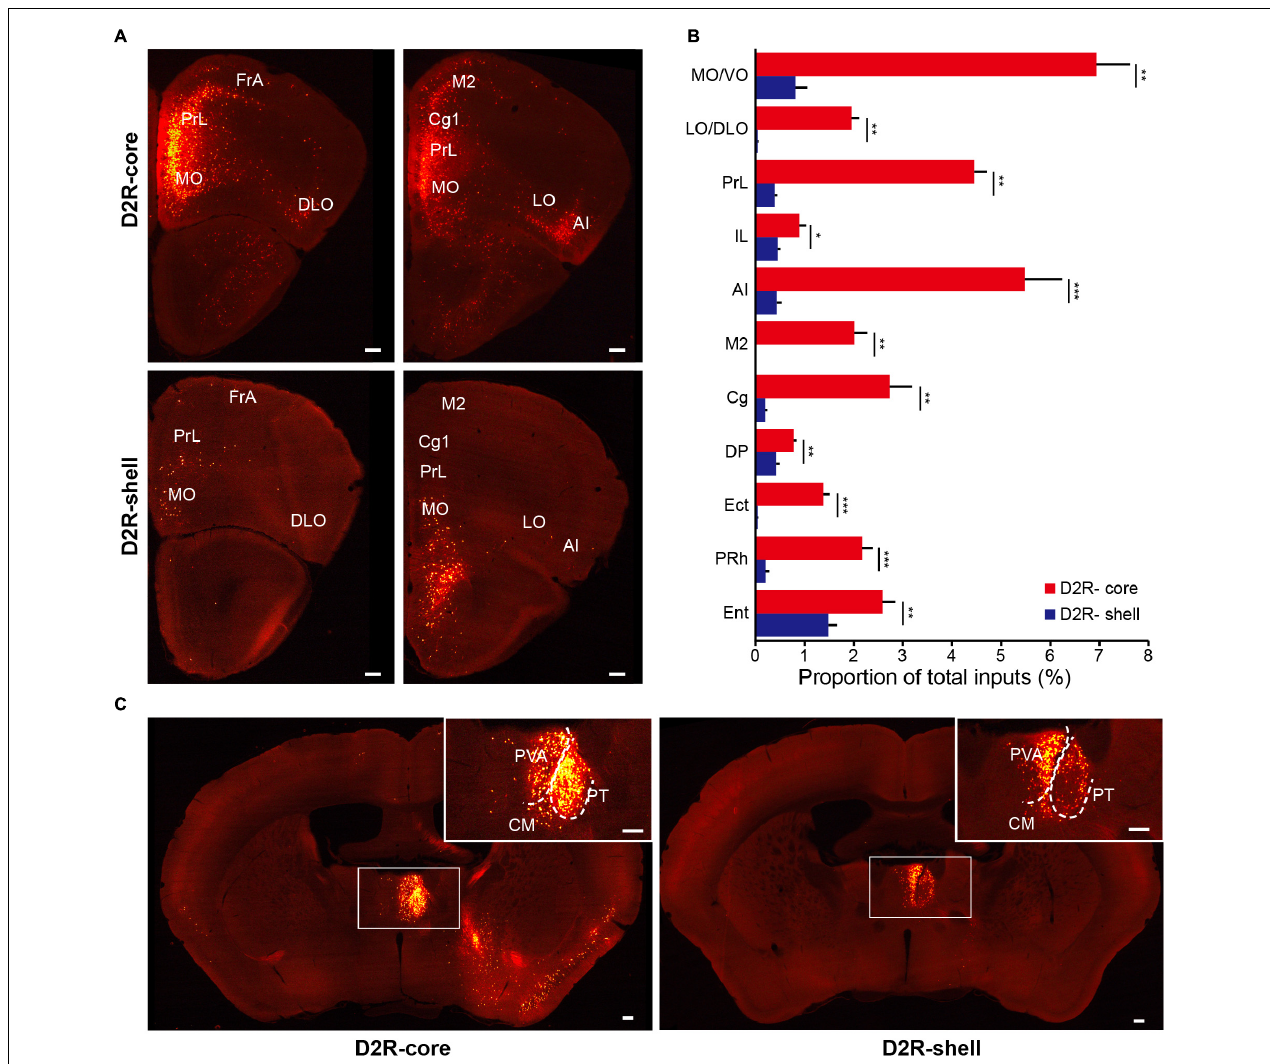
FIGURE 6 | Monosynaptic inputs to D2R-MSNs from the cortex and thalamus. (A) Distributions of anterior cortex inputs to D2R-MSNs in the NAc core (upper panels) and shell (lower panels). Scale bar, 200 µ m. (B) Proportion of total inputs to D2R-MSNs in the NAc core (red) and shell (blue) from 11 cortical areas that contained relatively large numbers of input neurons ( > 1% in at least one experimental group). Mean ± SEM ( n = 6 mice for each group). ∗∗∗ p < 0.001, ∗∗ p < 0.01, and ∗ p < 0.05, two-tailed unpaired t -test or Mann–Whitney U test. (C) Distributions of thalamic inputs to D2R-MSNs in the NAc core (right) and shell (left). Inset, enlarged view of the area in the white box showing spatially separated labeling. Scale bar, 200 µ